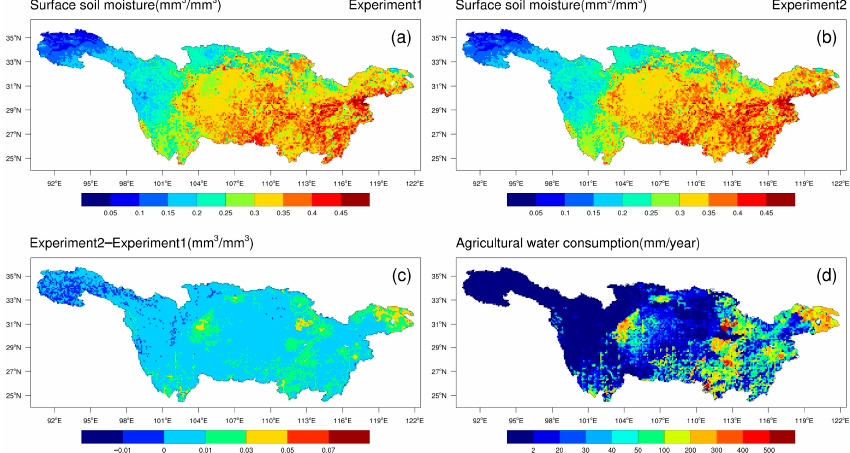
Figure 9. Spatial distribution of agricultural water consumption, surface soil moisture and its variation. ( a ) is Surface soil moisture for experiment1. ( b ) is surface soil moisture for experiment2. ( c ) is the difference of surface soil moisture between experiment1 and experiment2. ( d ) is mean annual agricultural water consumption.